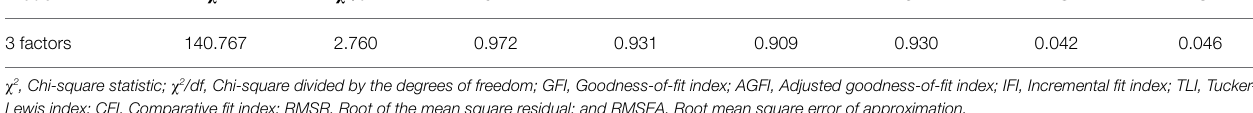
TABLE 1 | Goodness-of-fit indices for the proposed model, Questionnaire (CBAD-12A) by Álvarez et al. (2020). Model χ 2 χ 2 /df